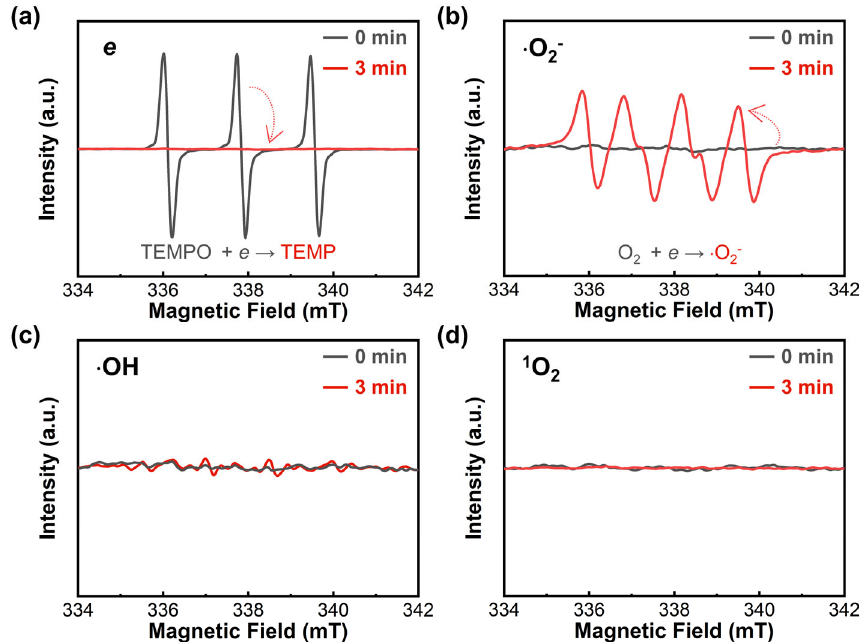
Figure 5. EPR signals for ( a ) e · trapped with TEMPO, ( b ) · O 2 − trapped with DMPO-MeOH, ( c ) · OH trapped with DMPO, and ( d ) 1 O 2 trapped with TEMP, obtained for Fe 3 O 4 @MoS 2 and corresponding trapping agent systems before and after 3 min of ultrasonic irradiation.